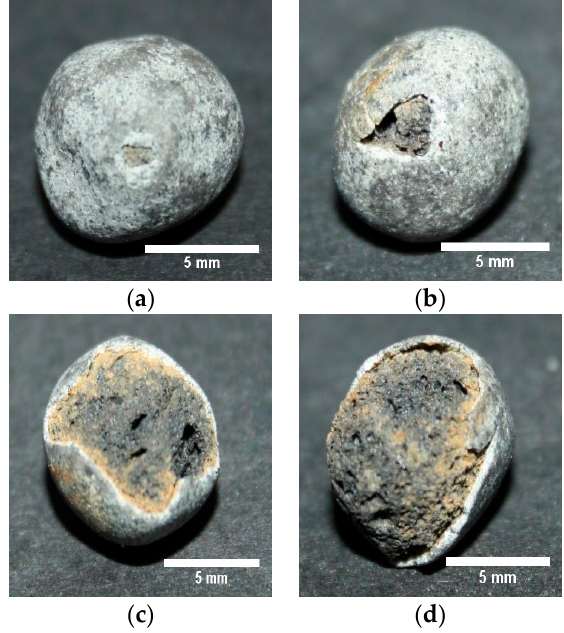
Figure 9. Fragmentation damage after Micro-Deval Showing ( a ) small pits ( b ) large pits ( c ) intermediate loss of coating and ( d ) significant loss of coating.